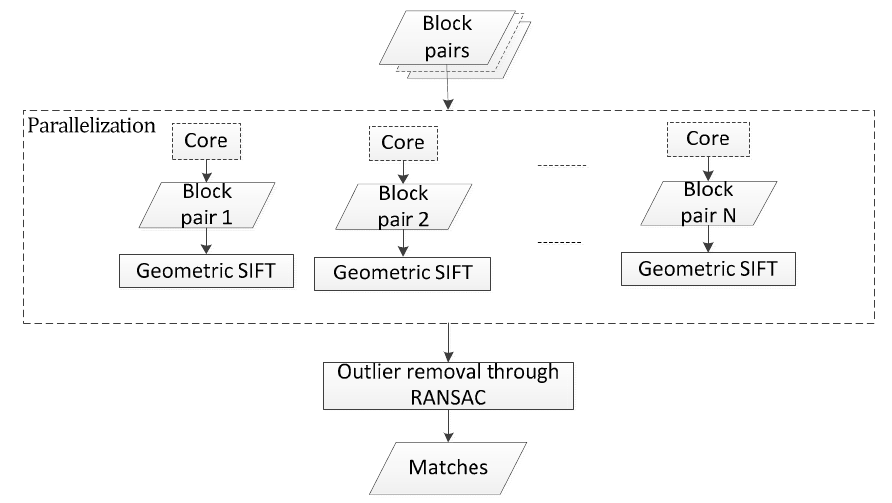
Figure 6. Flowchart of the parallel matching method.